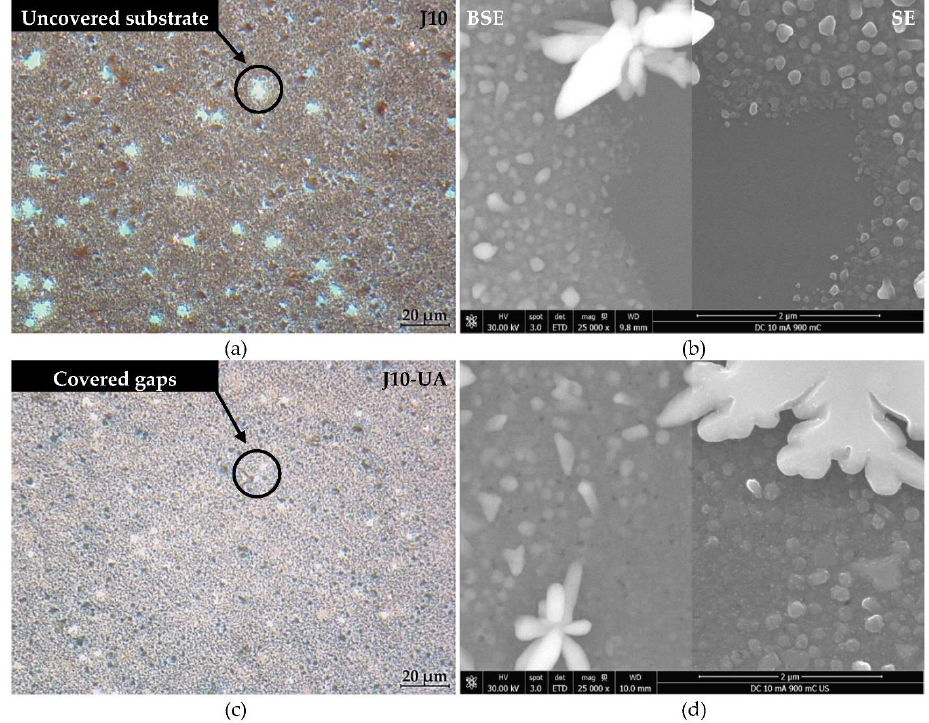
Figure 8. Digital optical microscopy images of the as-deposited Cu film obtained at 10 mA·cm −2 without agitation ( a ) and under ultrasonic electrolyte agitation ( c ). The same films observed at higher magnification by SEM in ( b ) and ( d ), respectively.